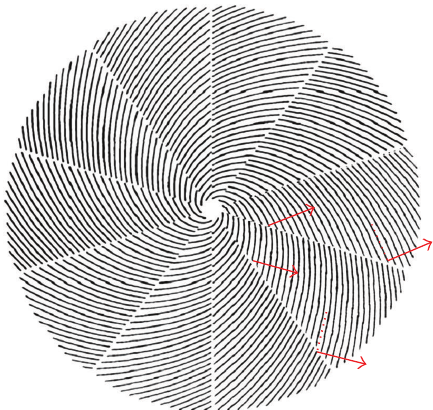
Figure 17: Segmented spiral grating that can used to introduce a constant azimuthal displacement between sheared wavefronts